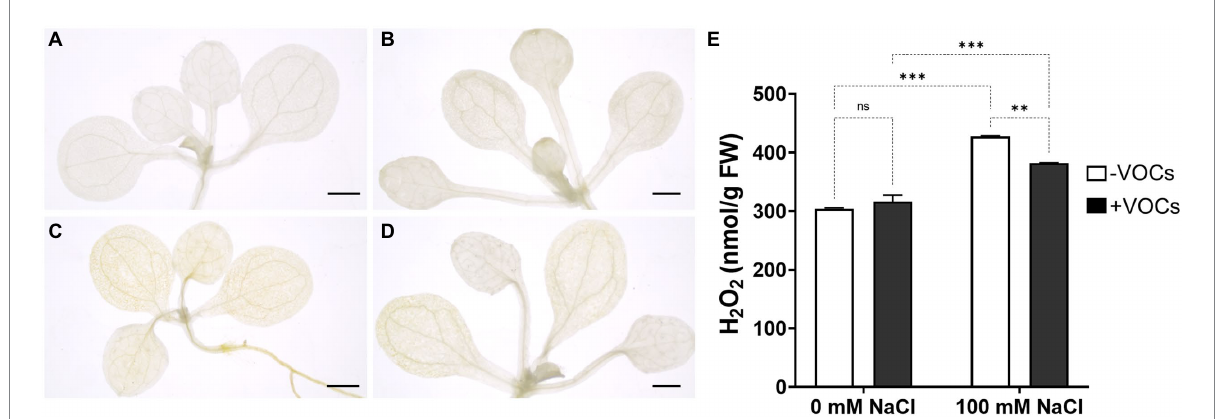
FIGURE 5 Effects of B. pyrrocinia CNUC9 VOCs on hydrogen peroxide (H 2 O 2 ) modulation in A. thaliana seedlings. (A–D) A. thaliana leaves stained with 3,3 ′ -diaminobenzidine (DAB) after seedling exposure to CNUC9 VOCs under no-stress and salt stress conditions for 10 days. (A) No VOCs exposure; 0 mM NaCl. (B) CNUC9 VOCs exposure; 0 mM NaCl. (C) No VOCs exposure; 100 mM NaCl. (D) CNUC9 VOCs exposure; 100 mM NaCl. Bar = 1 mm. (E) Quantification of H 2 O 2 production in A. thaliana seedlings after exposure to CNUC9 VOCs under no-stress and salt stress conditions. Error bars represent SEM of three independent biological replicates ( n = 20 seedlings per replicate). Asterisks on bars of the